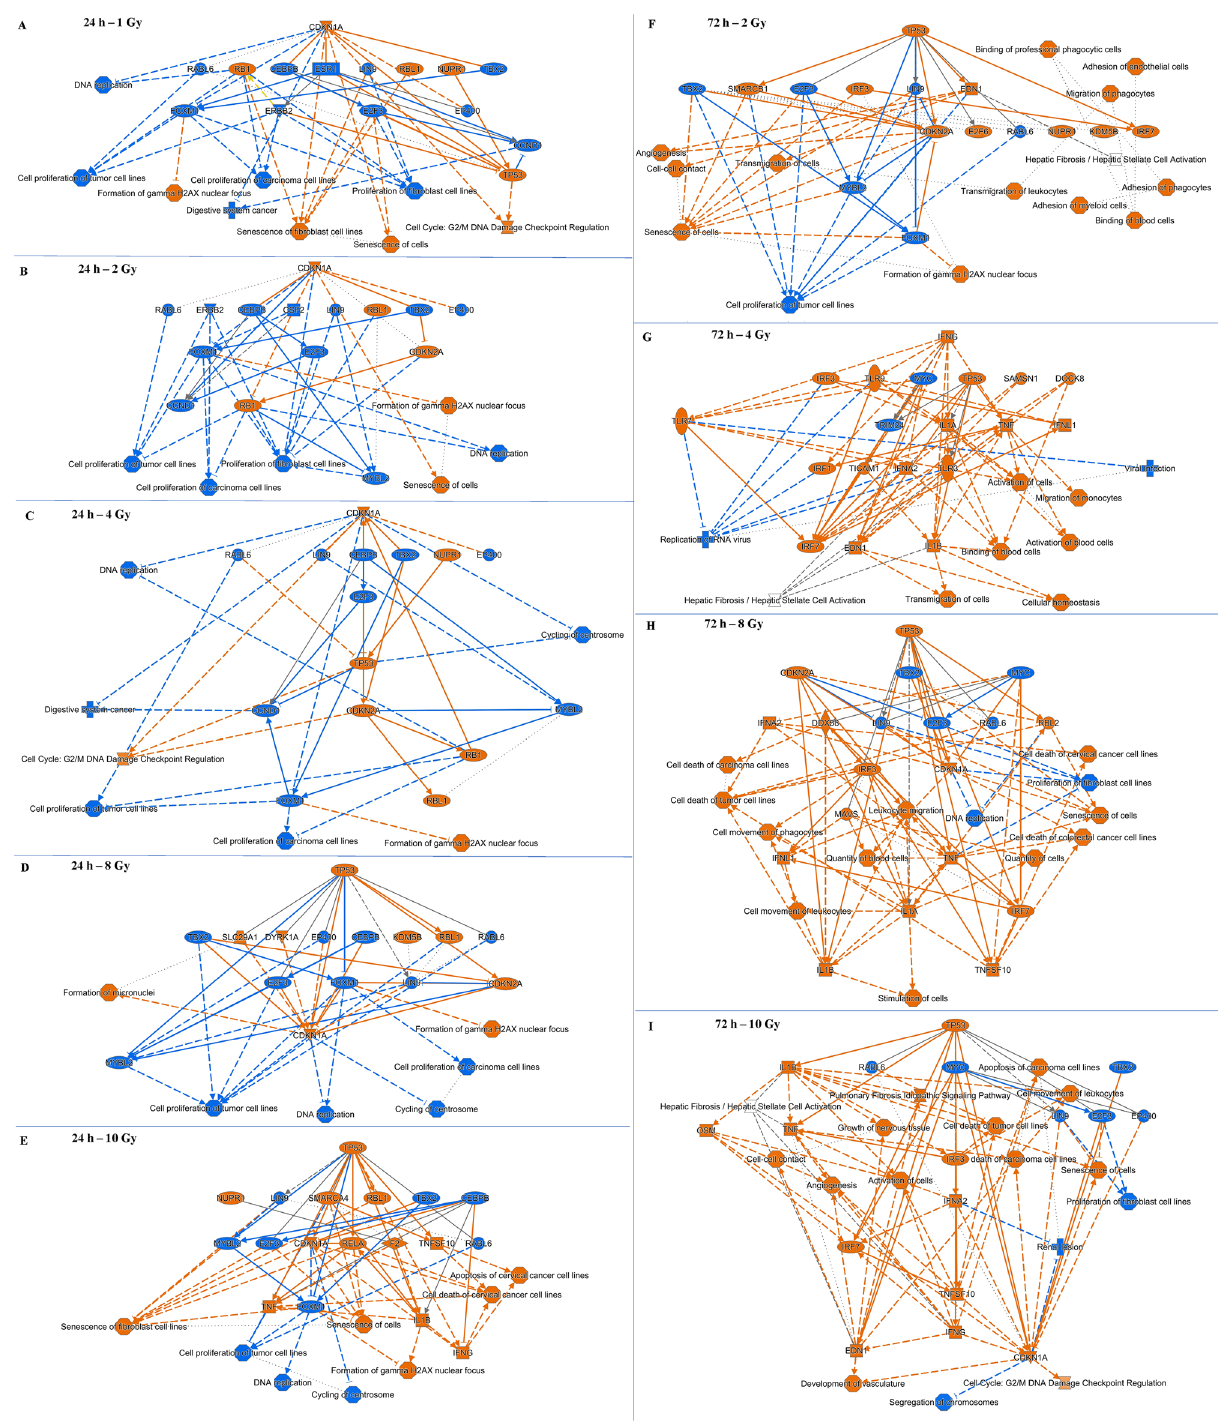
Figure 7. IPA generated graphical summaries for each dose-time-point combination. Core analysis was performed for each dose-time-point using differentially regulated mRNA lists. Graphical summaries include canonical pathways (Fisher’s exact test, p < 0.05) and upstream modulators (p < 0.05 and |z|= 2). Blue arrows and nodes indicate repressed activity; red arrows and nodes indicate induced activity; grey arrows suggest no definitive evidence on repression or activation. Solid arrows indicate direct interaction; dashed arrows indicate indirect interaction; dotted arrows indicate inferred and predicted